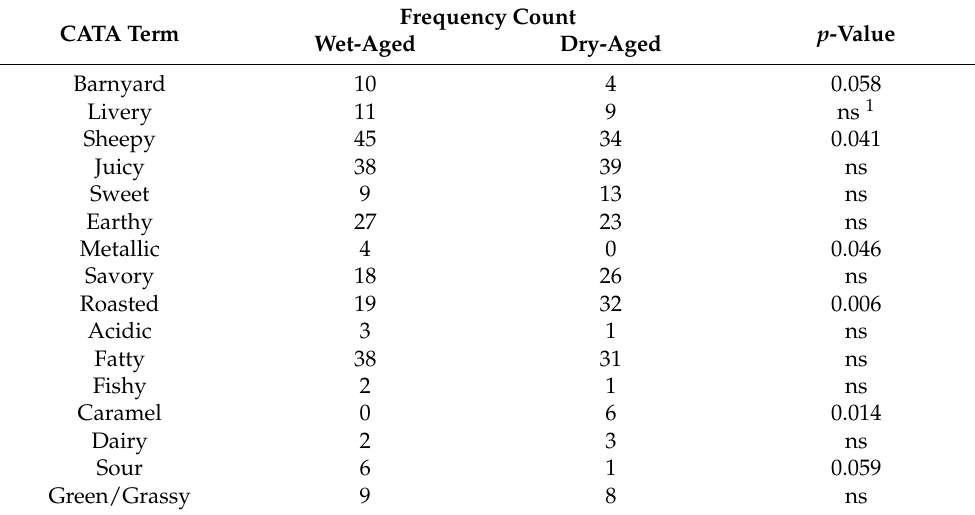
Table 3. Effect of ageing method (dry vs. wet) on frequency of selection (count) of check-all-that-apply (CATA) descriptor terms for cooked mutton patties and statistical significance ( p -value).